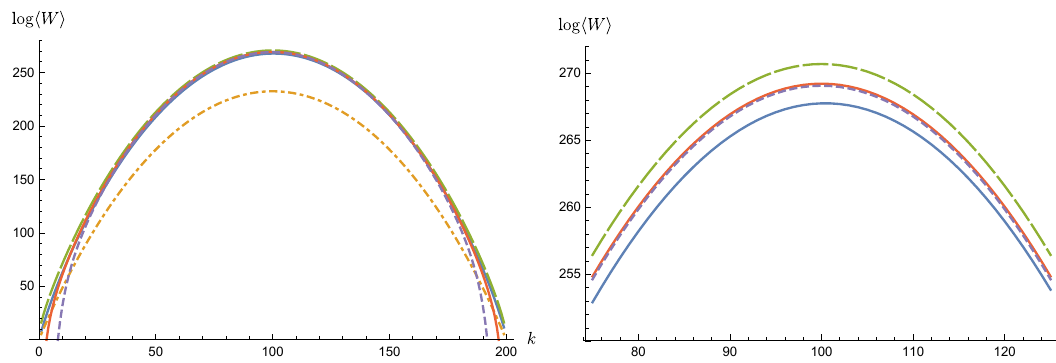
Figure 1 . Strong coupling expansion of (log W ) versus (log W ) , for N = 200, λ = 35. planar exact The right hand plot is a close-up of the middle region. The solid blue is the exact result log W evaluated numerically (see section 4). The orange, green, red and purple lines show, in order, the successive approximations to (log W ) given by (4.2). They clearly converge to a fixed residual planar with respect to the exact result, and this residual should be well approximated by the second square bracket in (2.13). We confirm this in section 4. In this and subsequent plots we omit the constant prefactor d A